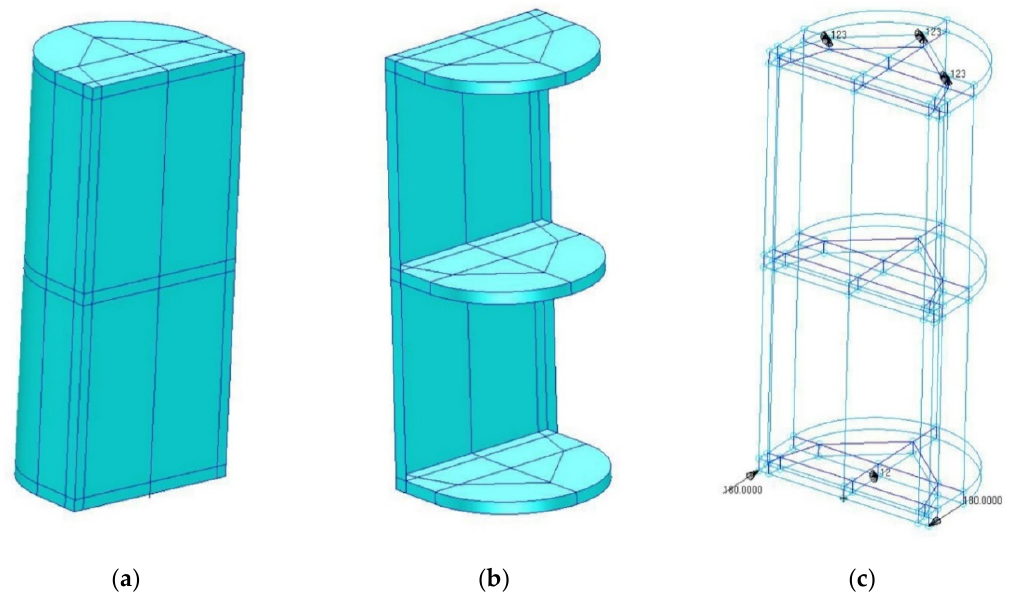
Figure 14. FEM geometric model: ( a ) general view; ( b ) model with a partially hidden shell; ( c ) model with visible edge conditions and loading.